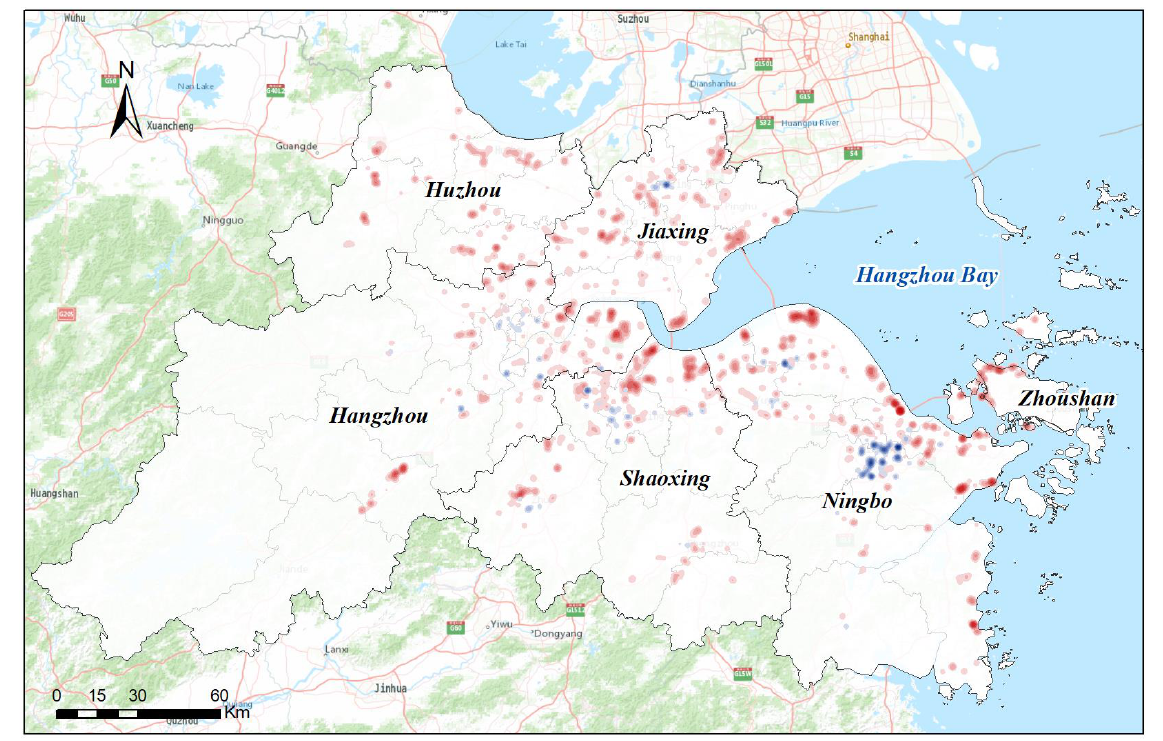
Figure 10. Industrial expansion and renewal intensity across the UAHB during 2010 – 2015. The red part (0~100%) represents expansion; the darker the red, the higher the intensity of industrial expan-